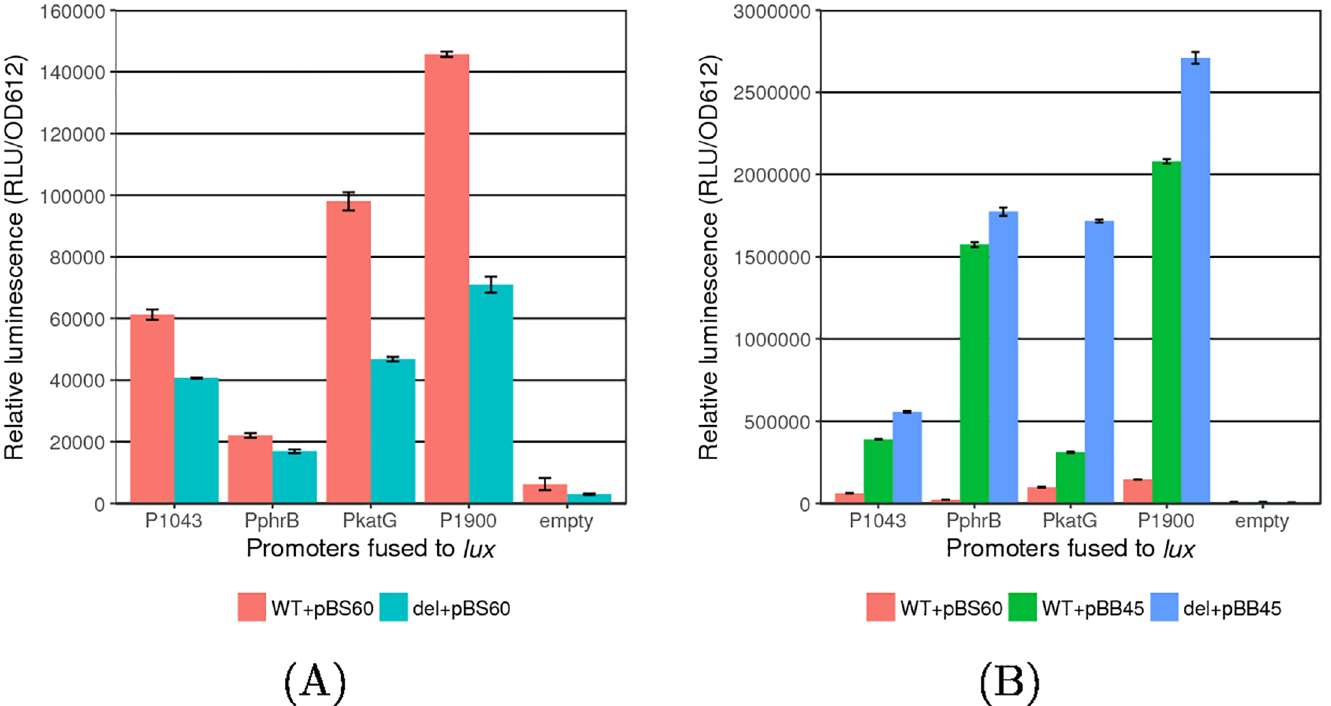
Fig 3. PSPTO_1043-dependent promoter activity. Candidatepromoter-containingregions were fused to the lux reporter gene in a plasmid. Lux expressionwas monitored after 6hr in WT or Δ PSPTO_1043/1042 strains carryingeither the plasmidoverexpressing PSPTO_1043 (PnptII-1043) or an empty vector. (A) A slight decreasein expressionwas observedin strains lackingPSPTO_1043/1042(green bars) comparedto WT (red bars) when no PSPTO_1043 was overexpressed. (B) Overexpression of PSPTO_1043 in both WT (green bars) and Δ PSPTO_1043/1042 (blue bars) results in increasedexpressionfrom all the tested promoterfusions compared to strains lackingthe overexpression construct (red bars).